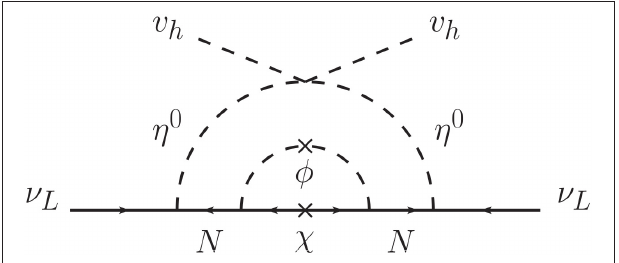
FIGURE 10 | Two-loop radiative neutrino mass of the model B. The upper cross means the soft breaking mass term m 2 4 , which should indicate that there are φ R and φ I loops in the inner one-loop diagram. The lower cross indicates the chirality flip of χ . The result (Equation 46) is obtained by using the exact propagators of φ s and χ